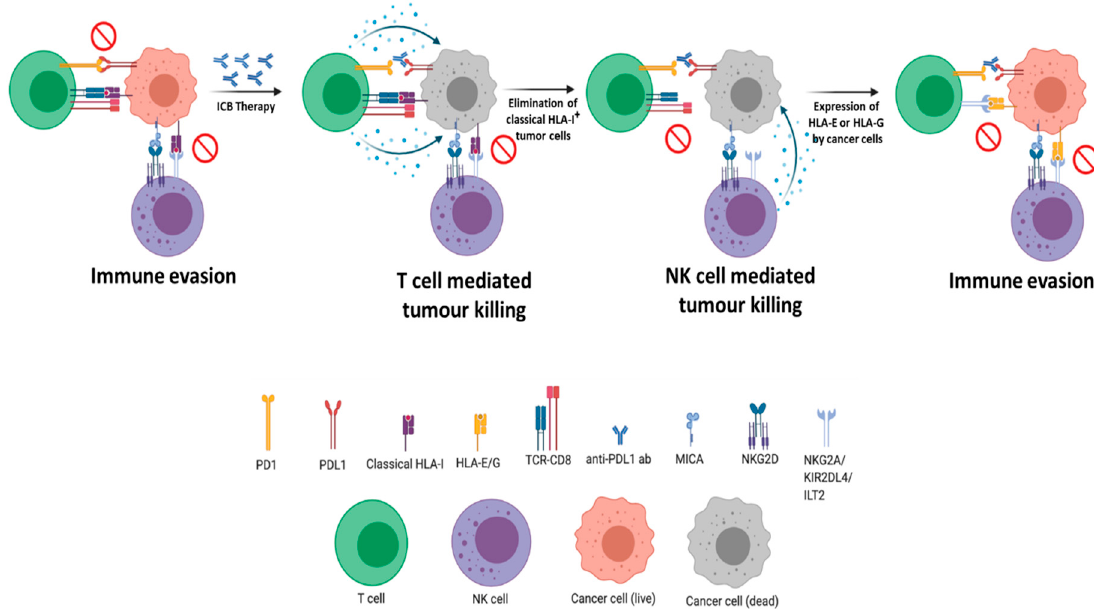
Figure 1. Overview of immune evasion strategies employed by tumor cells. T-cell mediated killing requires functional class I HLA and can be inhibited by tumor expression of immune checkpoints such as PDL1 (programmed death ligand 1). Immune activity in this situation can be restored using checkpoint inhibitor antibodies such as anti-PDL1. Similarly, NK (natural killer) cell-mediated cytotoxicity requires engagement via an NK cell ligand such as MIC-A (major histocompatibility complex class I polypeptide –related sequence A), coupled with the absence of class I HLA. Expression of the non-classical HLA haplotypes HLA-E or HLA-G (which are not generally recognized by the TCR (T cell receptor)) provide a simple mechanism for tumor cells to evade killing by both T-cells and NK cells. Additional abbreviations: ICB (immune checkpoint blockade), NKG2D (natural killer cell receptor G2 type D), KIR2DL4 (Killer cell immunoglobulin-like receptor 2DL4) and ILT2 (immunoglobulin-like transcript 2).